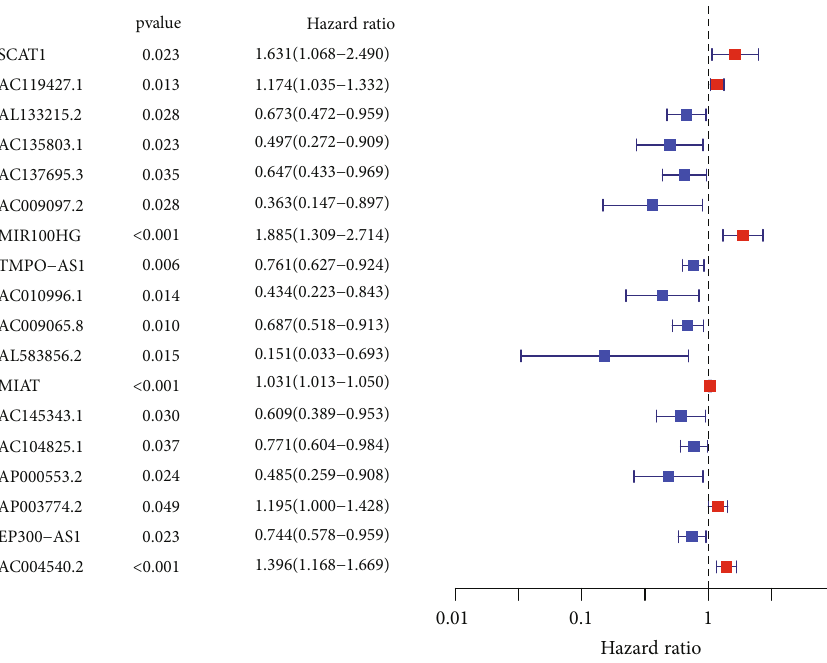
Figure 2: Univariate assays were applied to examine the survival-related FAM-related lncRNAs in